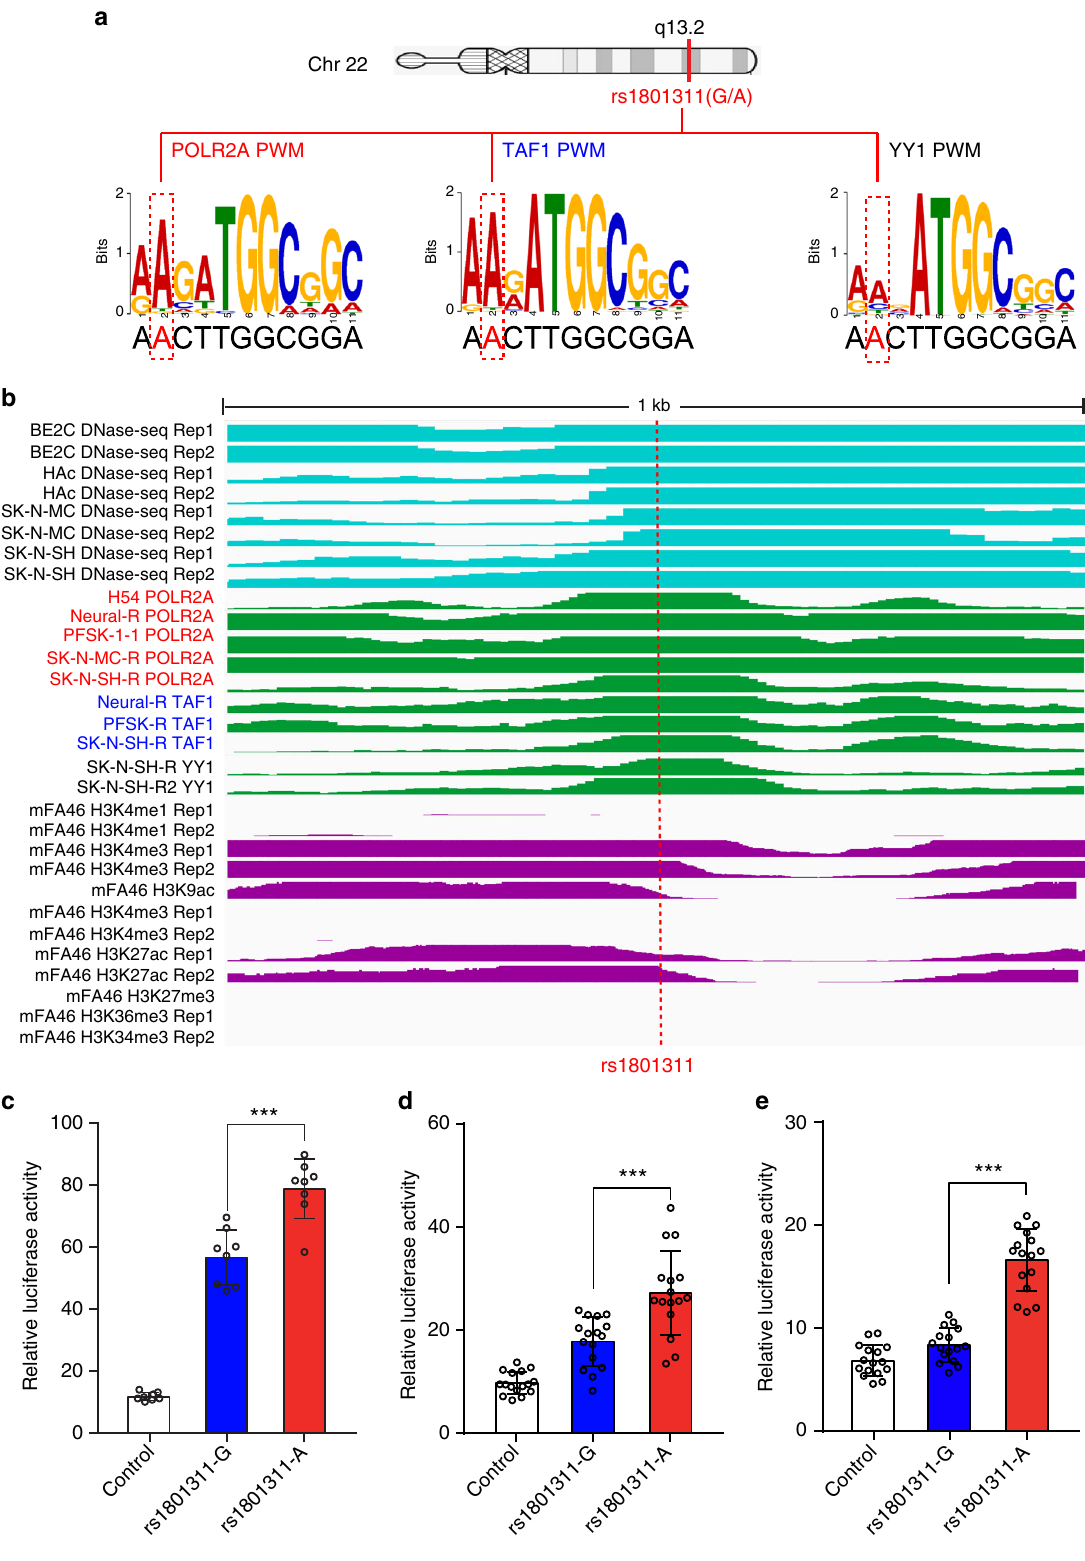
BE2C DNase-seq Rep2 HAc DNase-seq Rep1 HAc DNase-seq Rep2 SK-N-MC DNase-seq Rep1 SK-N-MC DNase-seq Rep2 SK-N-SH DNase-seq